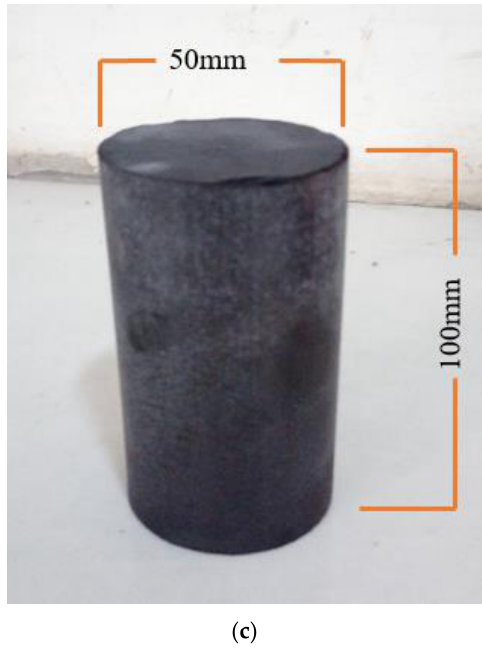
Figure 1. Manufacturing of coal samples. ( a ) Pressing coal samples; ( b ) stripping coal samples; ( c ) photographs of the coal samples.